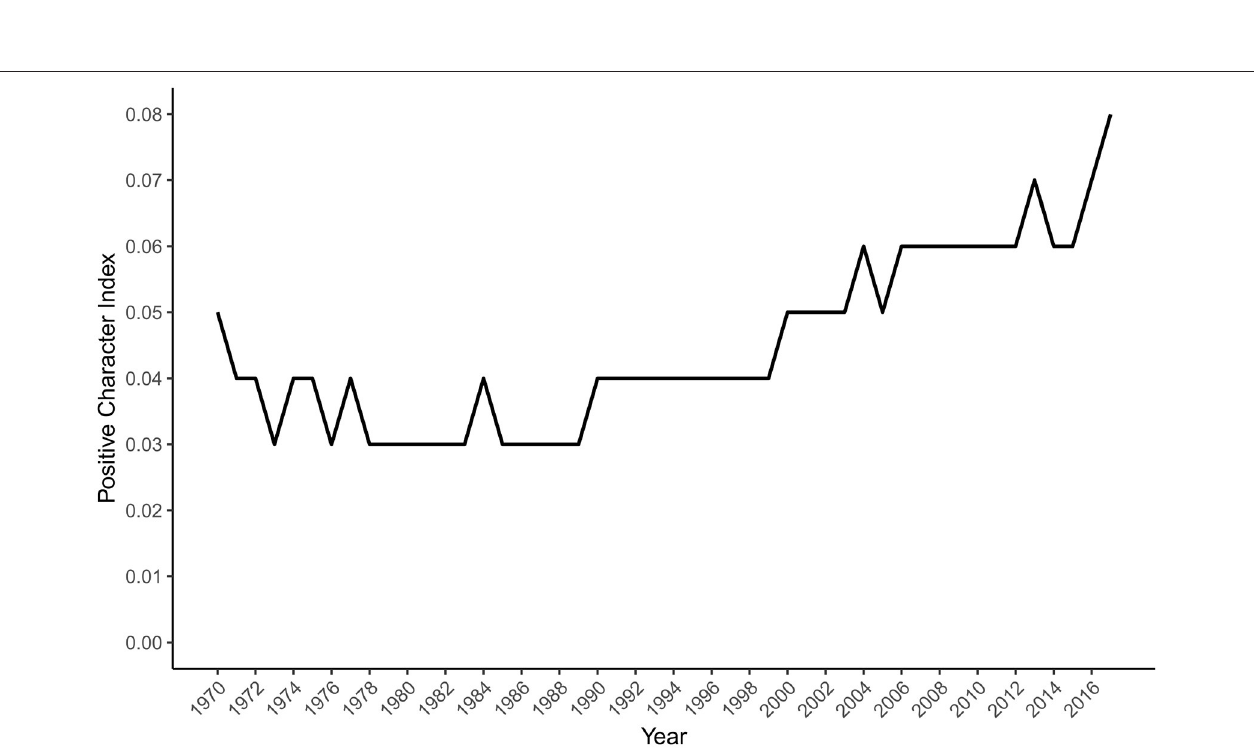
FIGURE 2 | The positive character index by